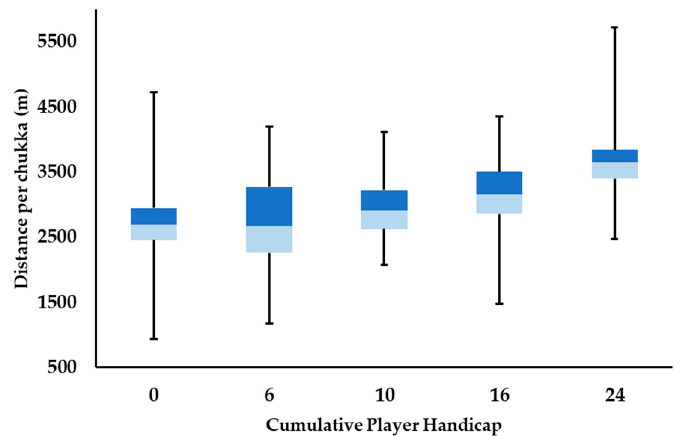
Figure 1. Box-plot of the median distance (m) per chukka at each level of play. Lower and upper box boundaries 25th and 75th percentiles, respectively, line inside box median, lower and upper error lines minimum and maximum, respectively. Table 1. Distance (m) covered in each speed zone, per chukka at each level of play. Data are presented as means ± 90% confidence intervals.